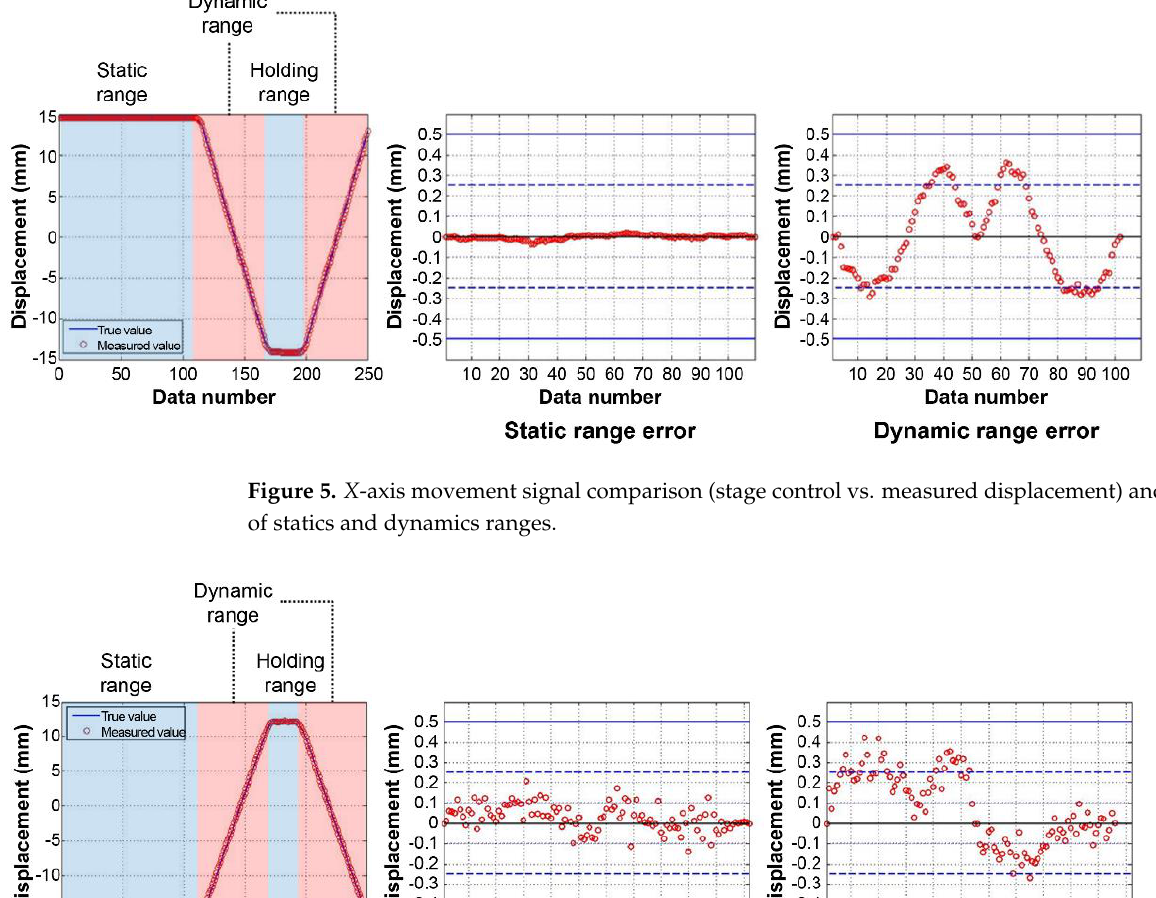
Figure 4. Motorized Stage along the X- and Y-axes and telescope of light source part .